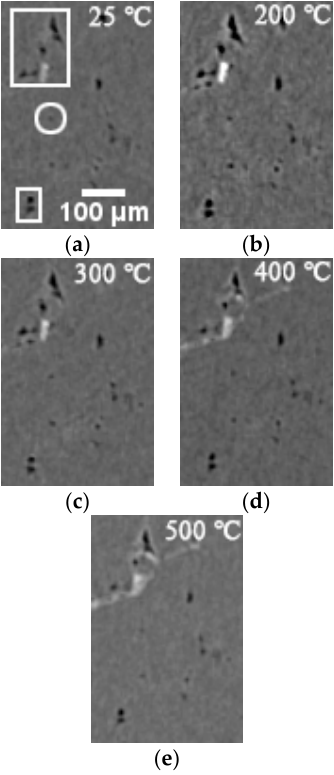
Figure 6. The CT images at different temperatures. ( a ) 25 °C. ( b ) 200 °C. ( c ) 300 °C. ( d ) 400 °C. ( e ) 500 °C.